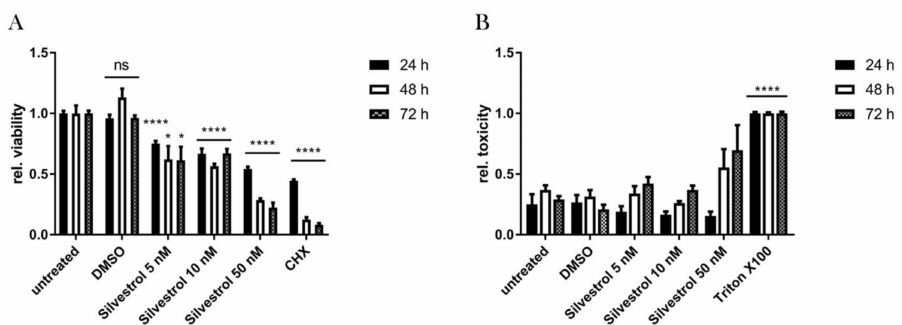
Figure 1. Cytostatic effect of silvestrol in A549 cells. ( A ) Time- and concentration-dependent decrease of cellular metabolic activity after silvestrol treatment in A549 cells determined by the PrestoBlue assay. Cycloheximid (CHX) served as positive control in a concentration of 35 µ M to inhibit cell proliferation; ( B ) Lactate dehydrogenase (LDH) release assay with the supernatants of silvestrol treated A549 cells did not show an increased cell death. Treatment with 1% Triton X-100 served as positive control for complete cell death. LDH activity in the samples was normalized to the LDH activity in the supernatant of Triton X-100 treated cells. ns = not significant = p > 0.05; * = p ≤ 0.05; **** = p ≤ 0.0001.